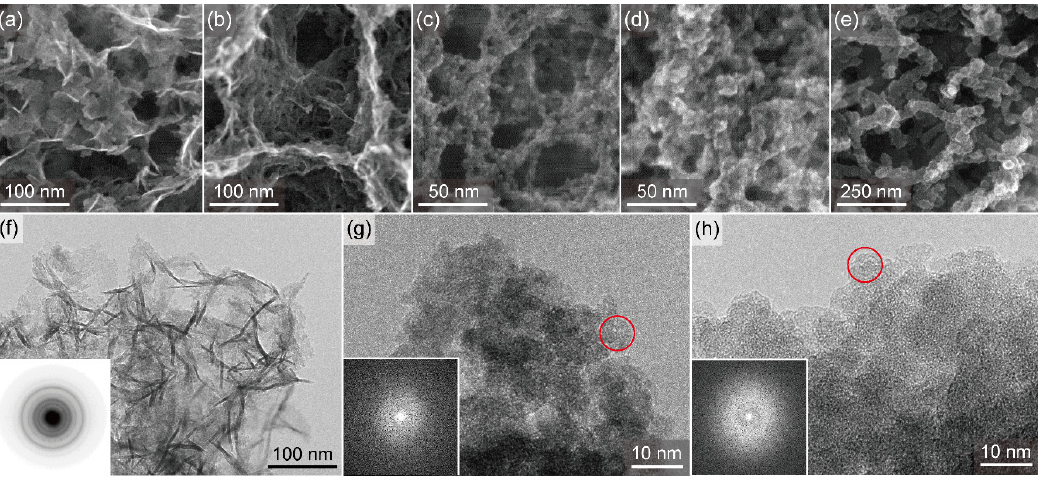
Figure 2. STEM and transmission electron microscopy (TEM) images of fibers covering the respective cultured sheath surfaces. Secondary electron images of outer surface texture of (( a ) Si-0, ( b ) Si-11.5, ( c ) Si-30, ( d ) Si-50, and ( e ) Si-300. TEM images of outer surface texture of ( f ) Si-0, ( g ) Si-30, and ( h ) Si-300. Note the crumpled sheets in the texture of Si-0 and the nanoparticles (circled) comprising the texture of Si-30 and -300. Inset: ( f ) electron diffraction (ED) pattern and ( g , h ) fast Fourier transform (FFT)